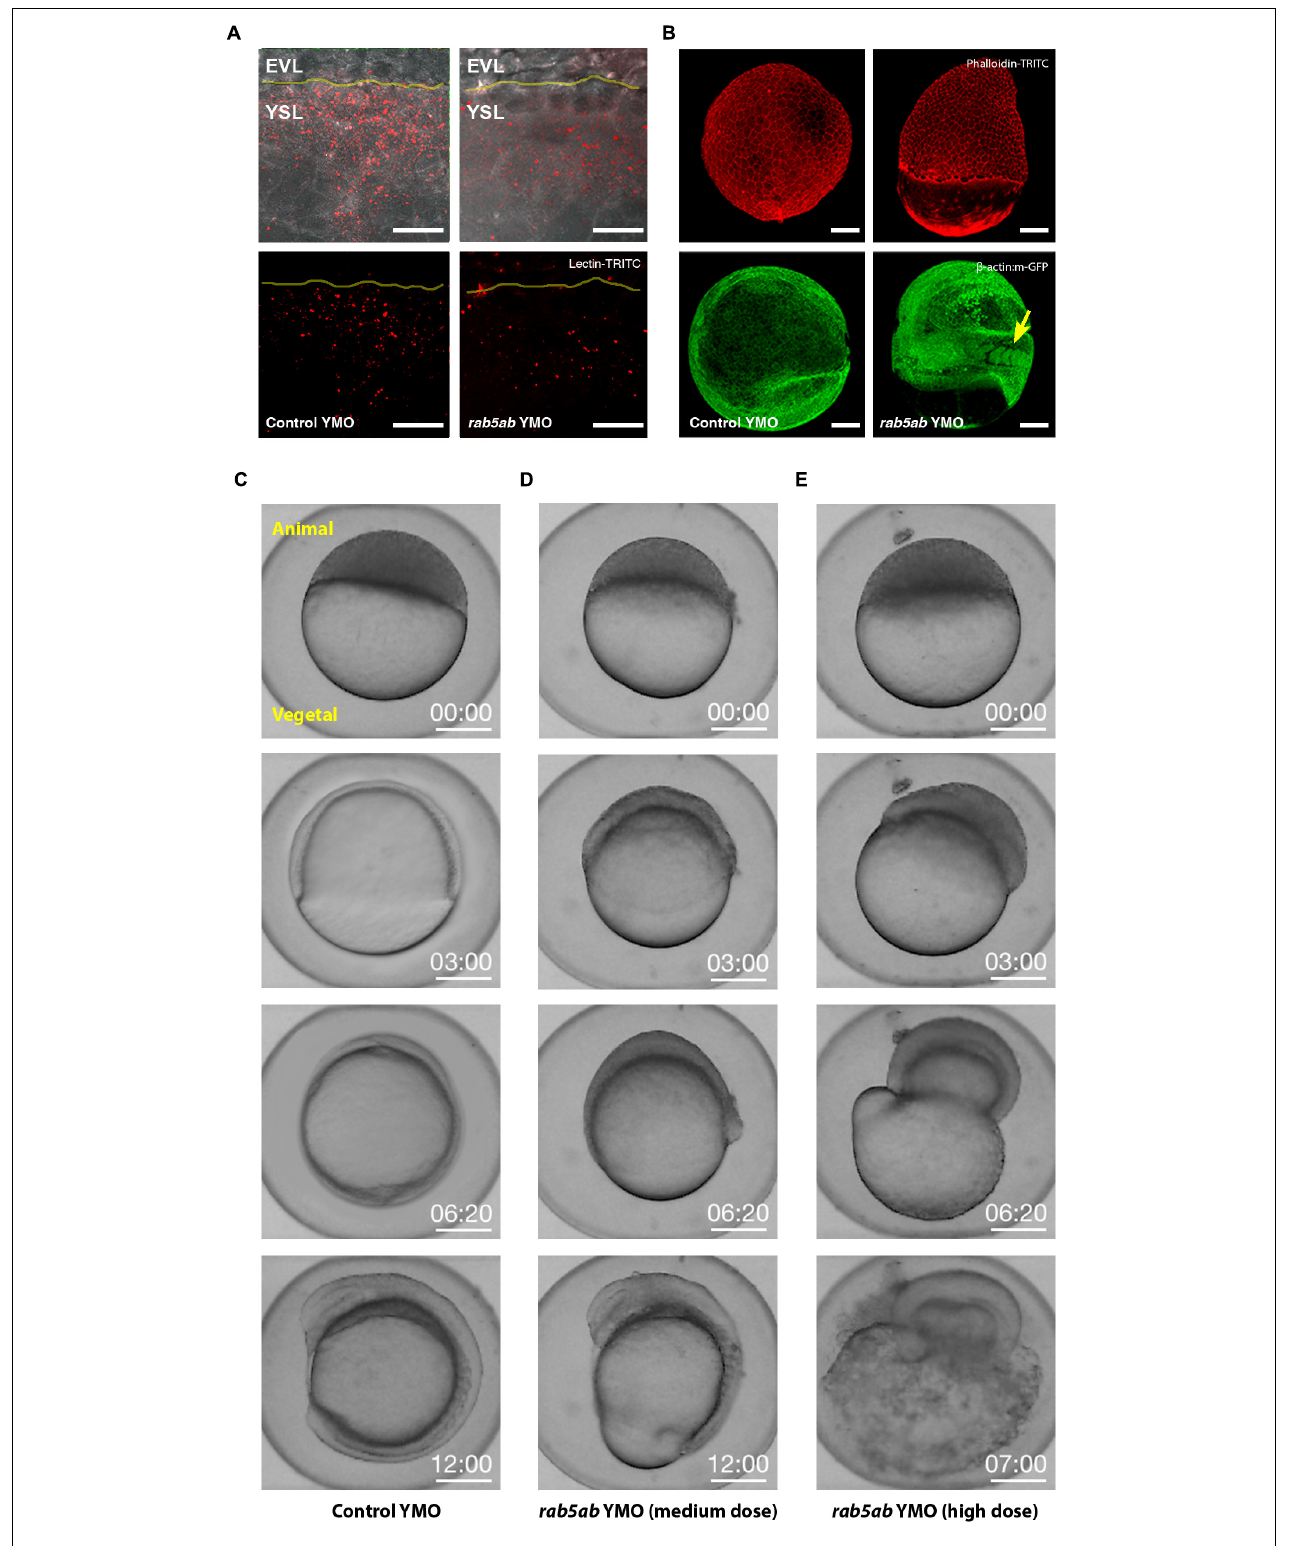
FIGURE 2 | Endocytosis and Epiboly are impaired after rab5ab depletion. (A) Lectin-TRITC internalization was reduced at doming stage in rab5ab (right) compared to sibling controls YMOs (left). EVL and the YSL are indicated. The EVL/YSL border is highlighted. Top panels show Lectin (red) and bright field overlays. Images